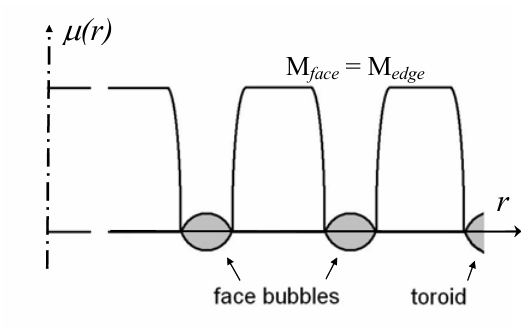
Figure 11. Chemical potential